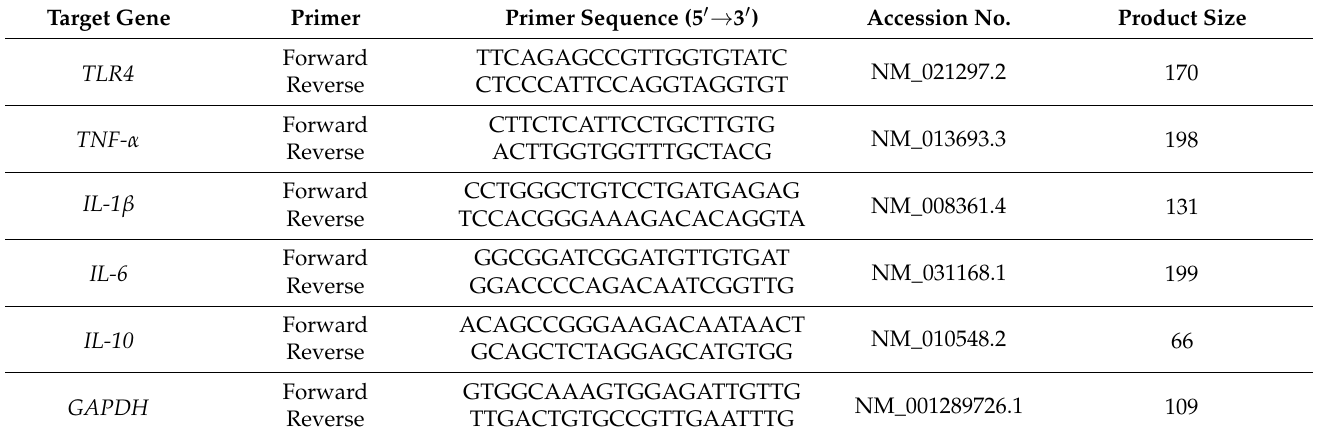
Table 1. The primers used for RT-qPCR